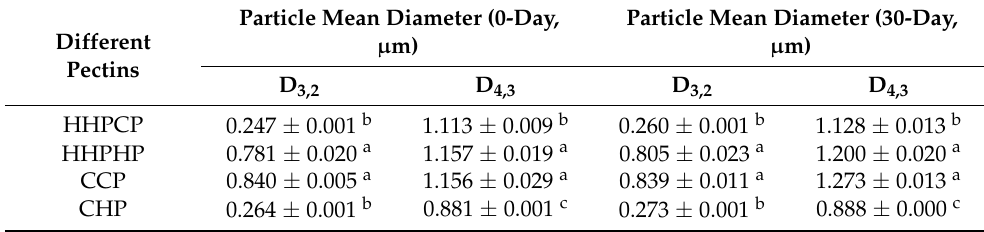
Figure 7. Particle size distribution of different pectin emulsions freshly prepared ( A ) and after stor- ( A’ ) at 4 ◦ C. age ( A’ ) at 4 °C. Table 2. Average particle size of O/W emulsions prepared from pectin extracted by different methods.